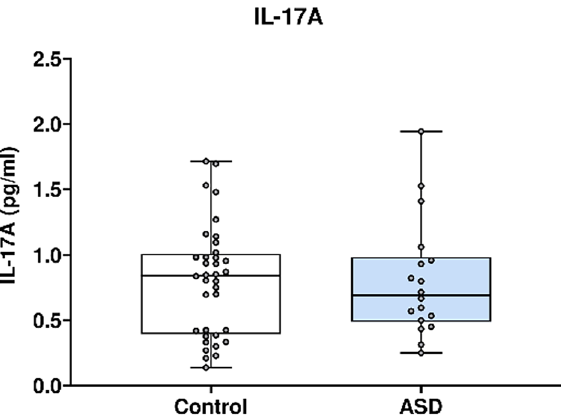
Figure 9. IL-17A concentrations from the multiplex analysis in ASD cases versus controls.